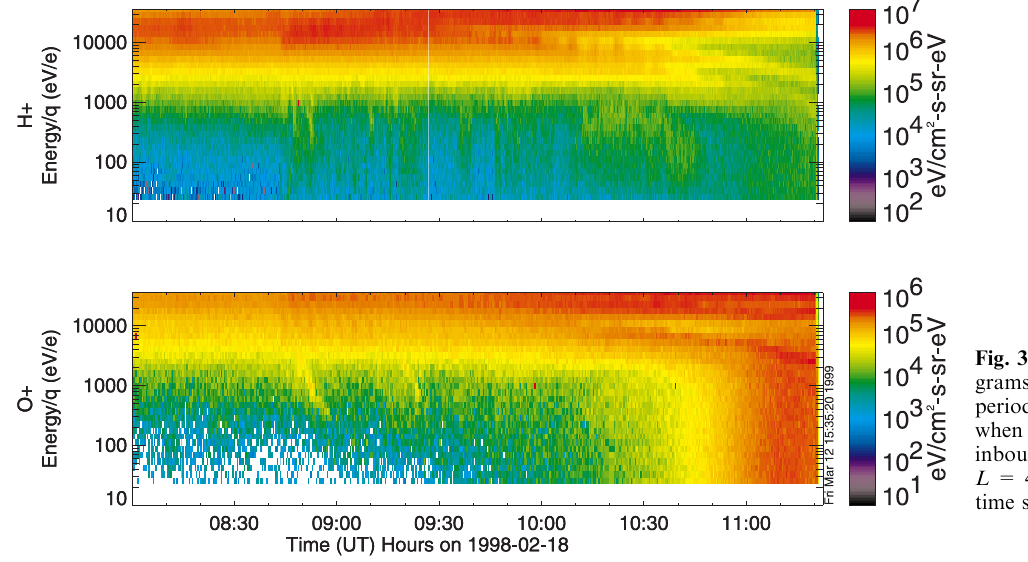
Fig. 3. Energy-time spectro- grams for H + and O + for a time period on February 18, 1998, when Equator-S was moving inbound from L = 8.3 to L = 4.0 in the pre-noon local time sector